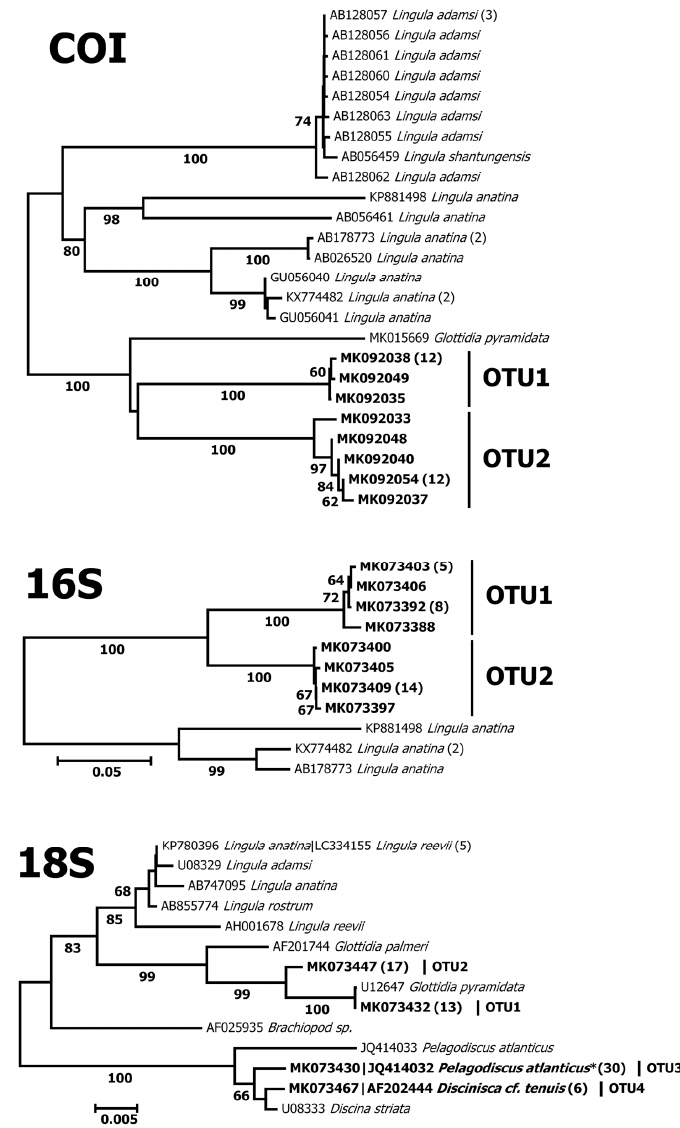
Figure 4. Neighbor ‐ Joining trees for cytochrome c oxidase subunit I (COI), 16S and 18S sequences from brachiopod larvae in this study with every brachiopod sequence available in GenBank. The tree shows only unique haplotypes, followed by the number of individuals with this haplotype in parentheses if ≥ 2. The Jukes ‐ Cantor distance between haplotypes is proportional to the length of the branches separating them, as shown in the scale bars at the bottom left. Bootstrap support values over 60% are shown below the corresponding branches. OTUs comprised of our sequences are indicated in bold. * This OTU had 100% sequence identity with one sequence from material identified as Pelagodiscus atlanticus and with one sequence from material identified as Discinisca cf. tenuis .